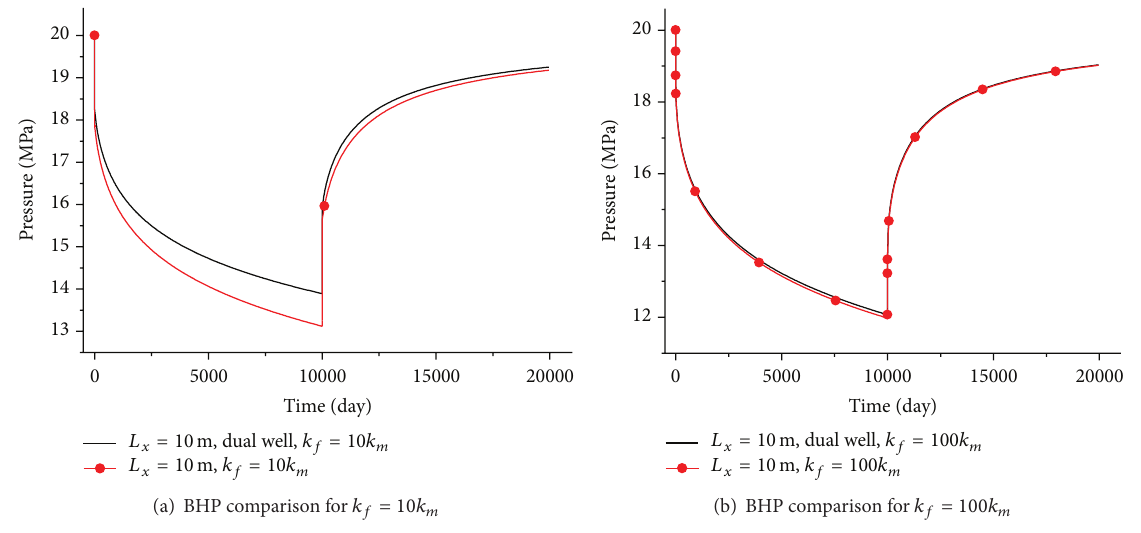
Figure 5: Effect of flow during matrix and wellbore under 𝐿 𝑥 = 10 m and 𝑄 = 50000 m 3 /